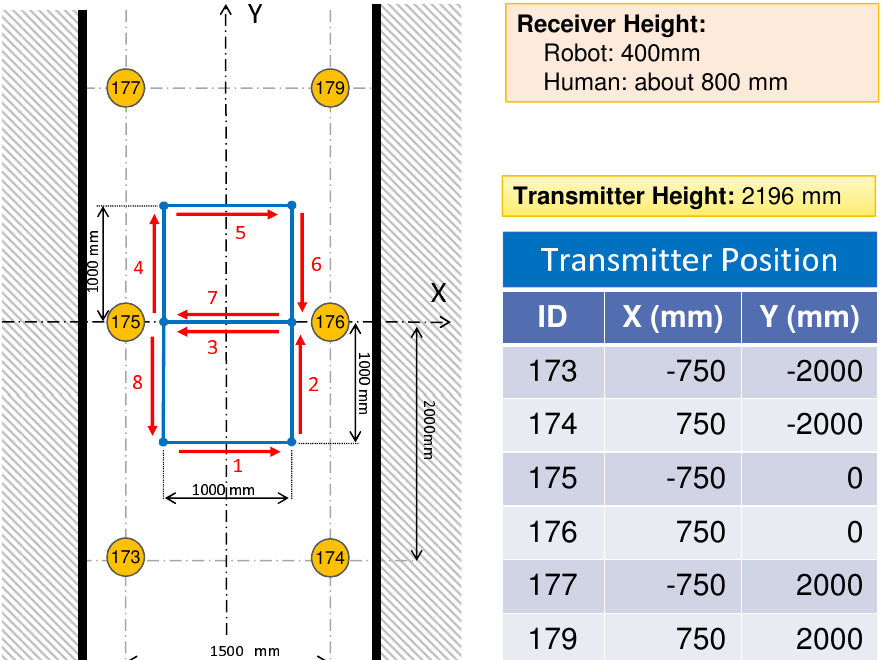
Figure 8. Experimental setup for robot and pedestrian